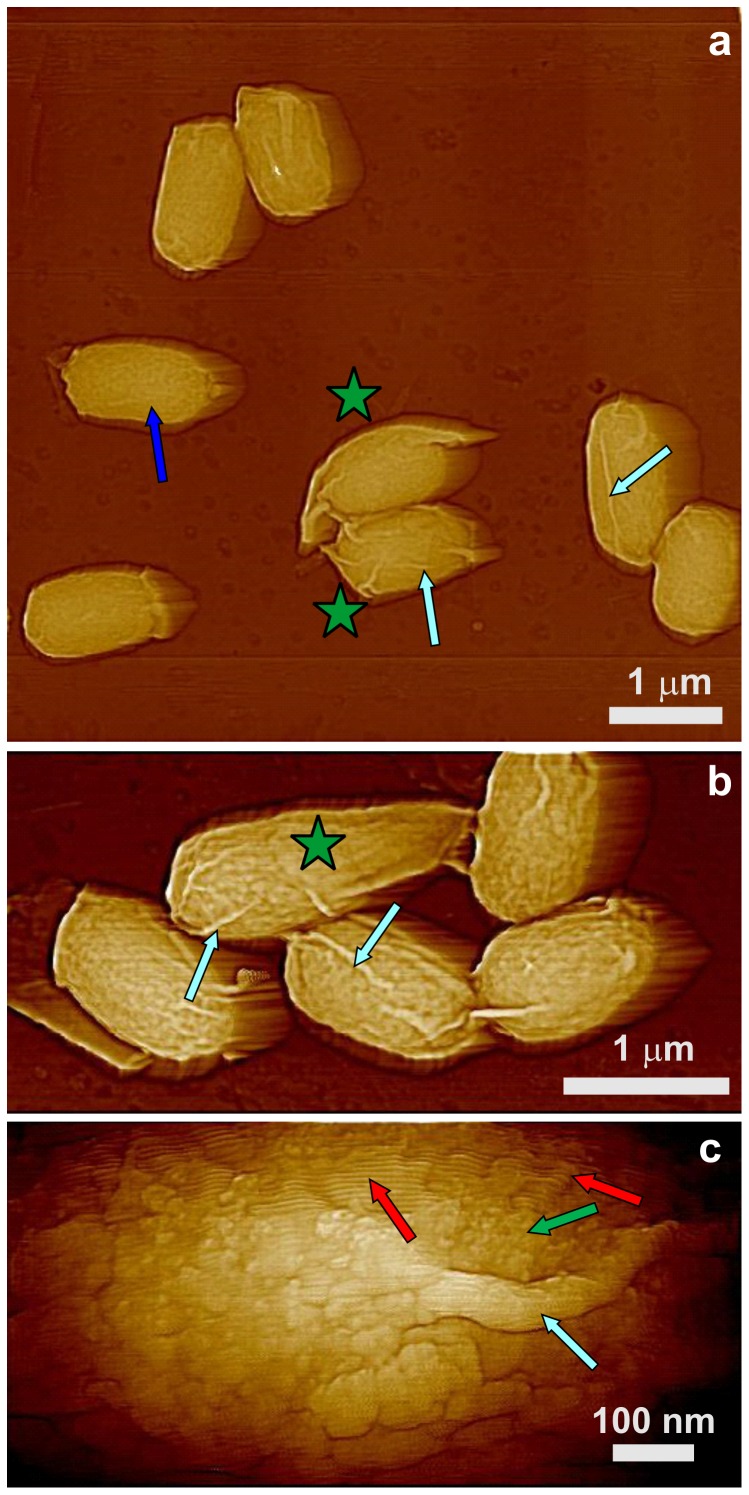
AFM height images of safA spores.(a–c) Several surface ridges are indicated with light blue arrows, and in (a) and (b) spores with an oversized sacculus are marked with adjacent green stars. A spore with at most minimal ridges is indicated with a dark blue arrow in (a). In panel (c), two patches of rodlet structure are indicated with red arrows, and a patch of an amorphous layer is indicated with a green arrow.